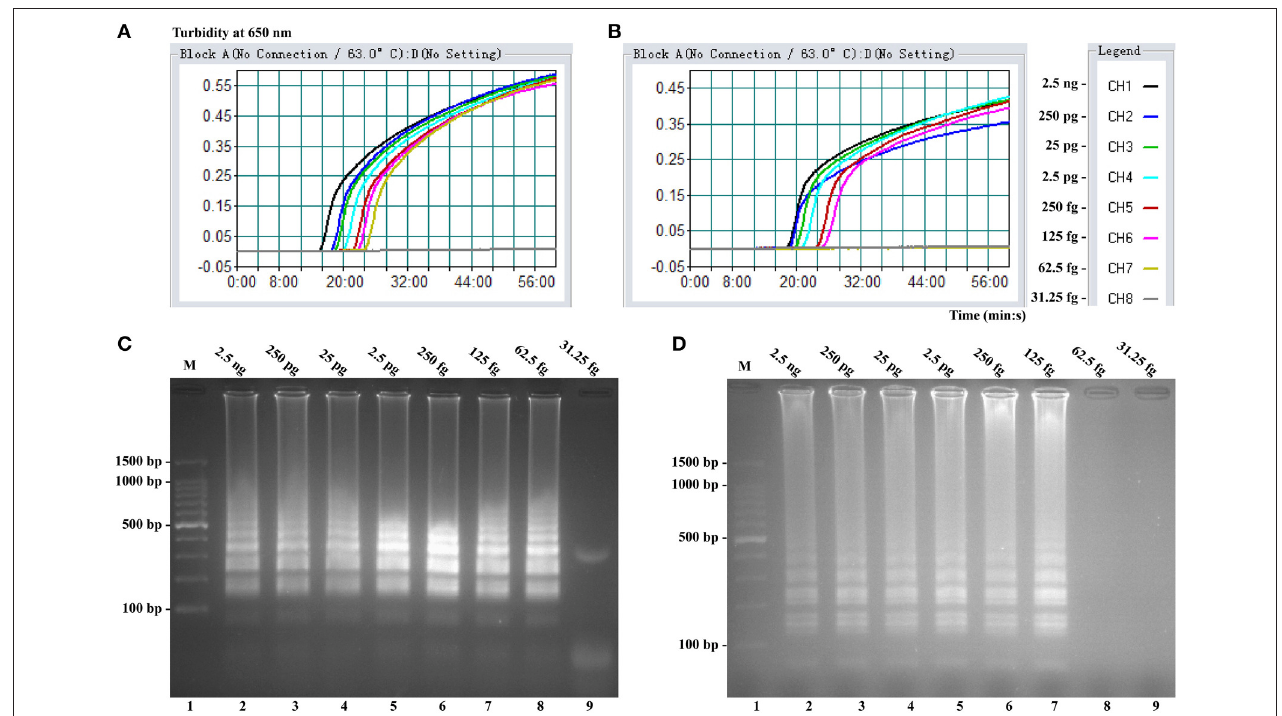
FIGURE 3 | Sensitivity of the ipaH - and invA -LAMP assays using serially genomic DNA with Shigella strains and Salmonella strains as templates. Sensitivity of ipaH -LAMP (A) and invA -LAMP (B) for Shigella and Salmonella detection was analyzed by real-time measurement of turbidity and the corresponding curves of concentrations of genomic DNA were marked in the figure. The LoD of ipaH -LAMP assay was 62.5fg per tube, and the invA -LAMP for 125fg per reaction. Sensitivity of ipaH -LAMP (C) and invA -LAMP (D) for Shigella and Salmonella detection was monitored by 2% agarose gel electrophoresis, and the positive amplifications were seen as a ladder-like pattern on 2% agarose gel electrophoresis analysis. Lane 1, DL 100-bp DNA marker.